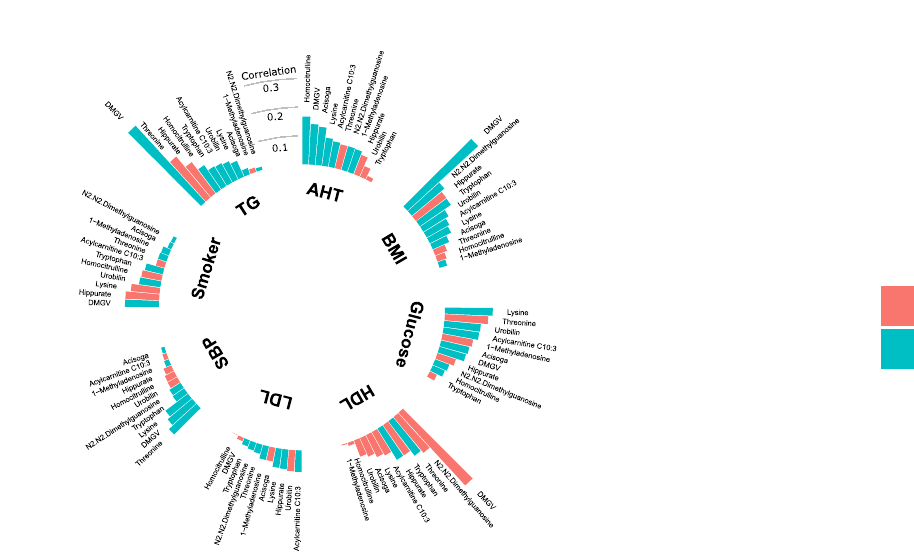
Figure 3. Correlations between plasma levels of 11 plasma metabolites and BMI, smoking status (Smoker), systolic blood pressure (SBP), anti-hypertensive treatment (AHT) and fasting levels of high-density lipoprotein cholesterol (HDL), low-density lipoprotein cholesterol (LDL), triglycerides (TG) and glucose in the Malmö Diet and Cancer-Cardiovascular Cohort ( n = 374). Correlation coefficients are either partial Spearman’s correlation coefficients (BMI, glucose, HDL, LDL, TG, SBP) or partial Pearson’s correlation coefficients (Smoker and AHT), adjusted for age and sex.